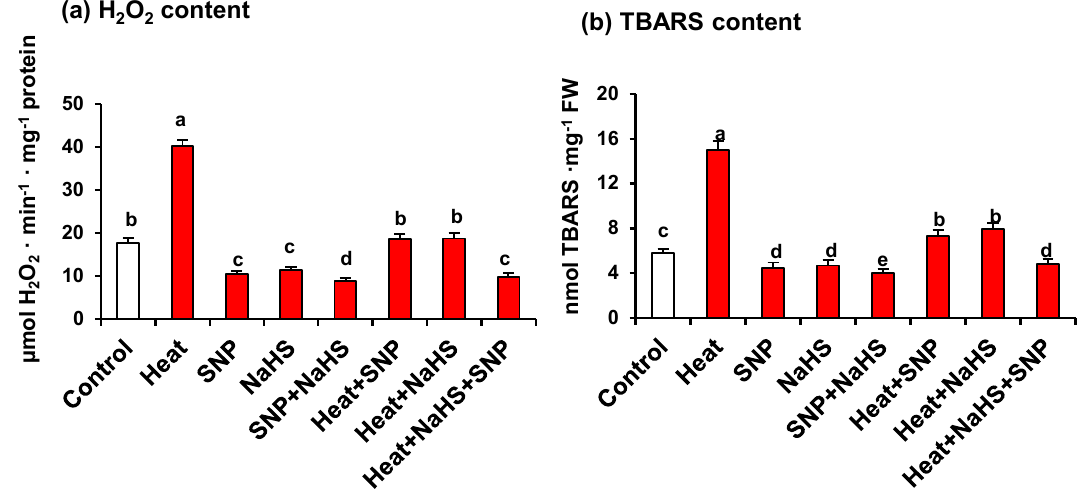
Figure 5. ( a ) H 2 O 2 and ( b ) TBARS content in wheat ( Triticum aestivum L. var. WH 542) leaves treated with SNP (100 µ M) and/or NaHS (200 µM) in the presence (40 °C) or absence (25 °C) of heat stress at 30 days after sowing (DAS). Data are presented as treatments mean ± SE ( n = 4). Data followed by the same letter are not significantly different by LSD test at ( p < 0.05). SNP, sodium nitroprusside; NaHS, sodium hydrosulfide. FW, fresh weight.